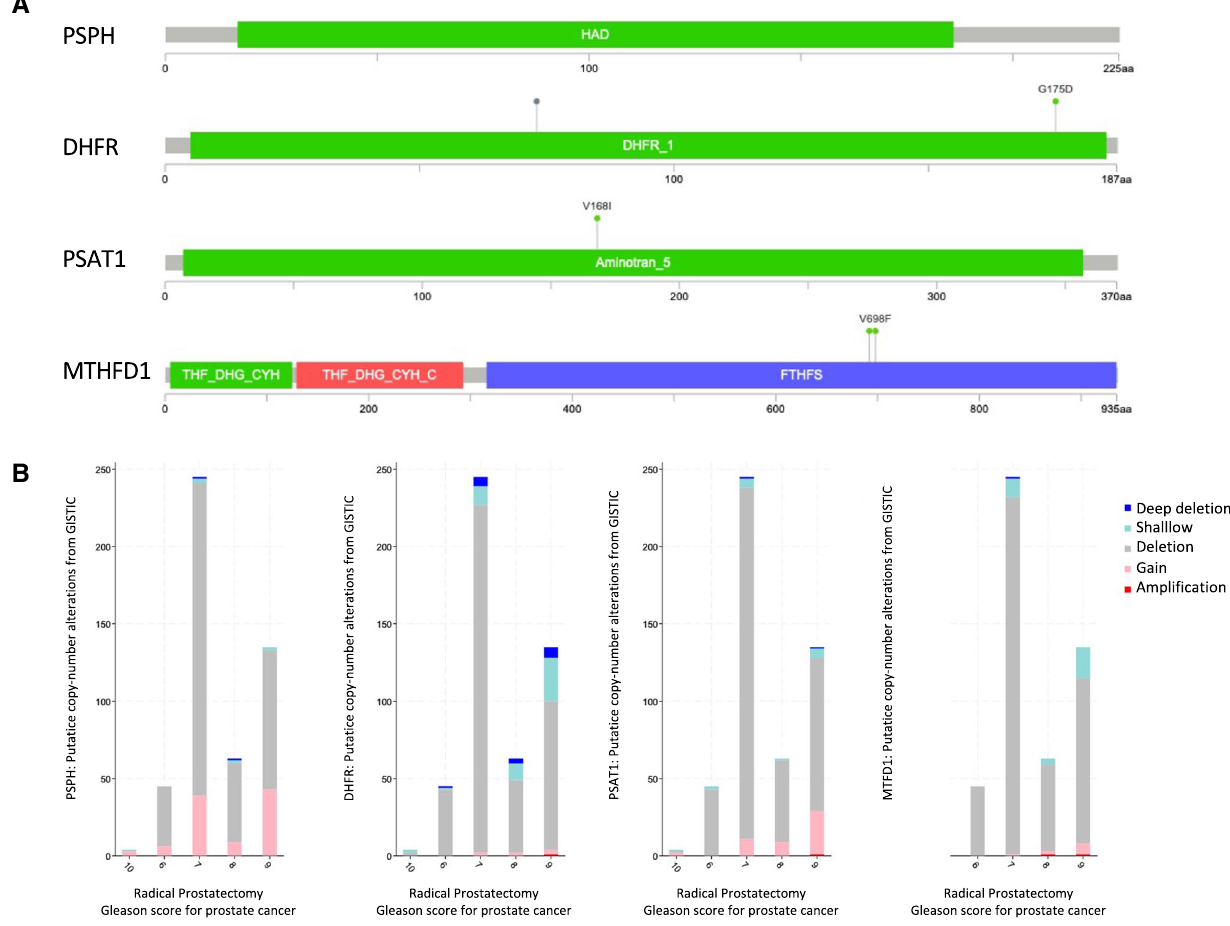
Fig. 3 One-carbon metabolism enzymes mutations and correlation with Gleason score. A Schematic representation of the top four altered one-carbon metabolism genes and mutations in the TCGA analysed cohort; B putative copy-number alterations number of samples over the total 499 samples analysed in the TCGA Firehose Legacy cohort, of the top four altered one-carbon metabolism genes in groups of pros- tate cancer patients stratified according to Gleason score after radical